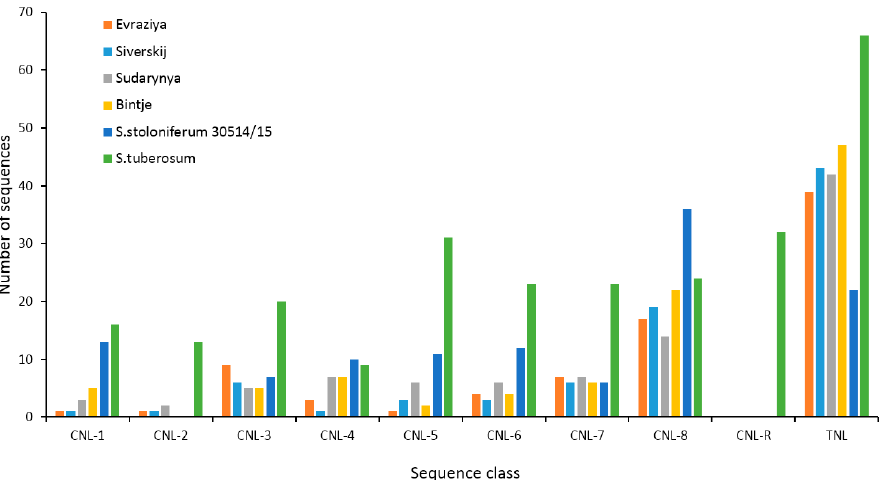
Figure 4. The distribution of the numbers of NBS-LRR novel sequences from five investigated genotypes and S. tuberosum between different NB-ARC classes according to [13]. X -axis: protein class; Y -axis: number of sequences. The bar colors for different genotypes are shown in the left top part of the plot.